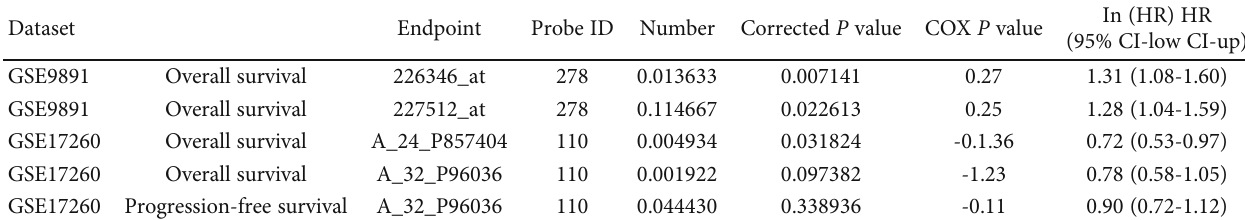
Table 1: Survival analysis of MEX3A mRNA in multiple